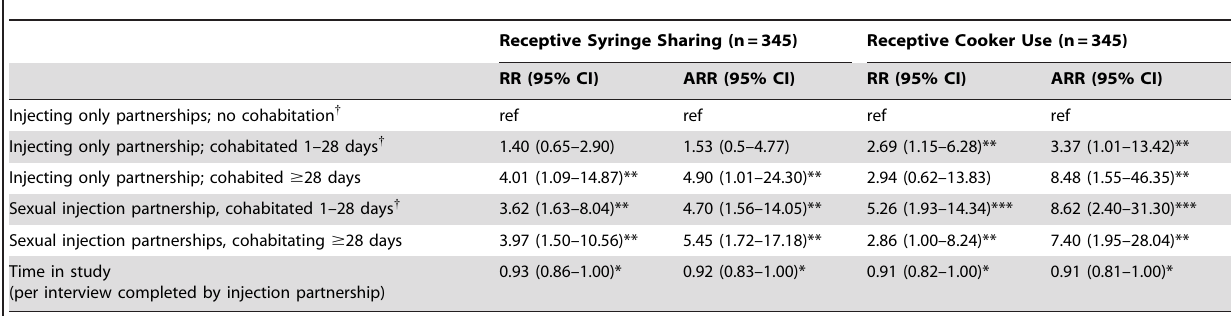
Table 4. Multi-level multivariate models for recent high rink injecting behaviors.